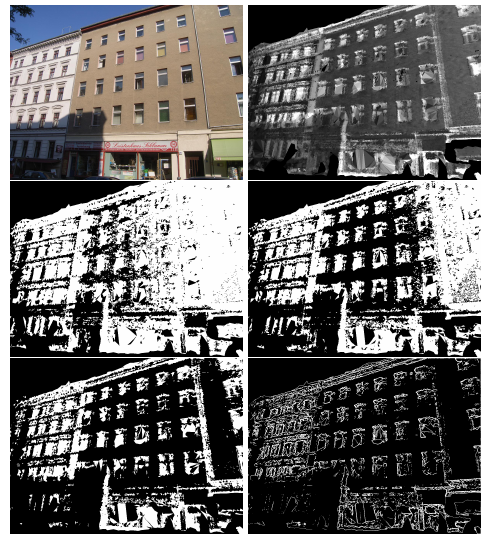
Figure 10. From top left to bottom right: fac¸ade image, visual- ization of colour differences to complete sequence, segmentation of colour difference image using the 0 . 3 , 0 . 5 and 0 . 7 quantiles of pixels unequal 0 , image with gradient magnitudes.